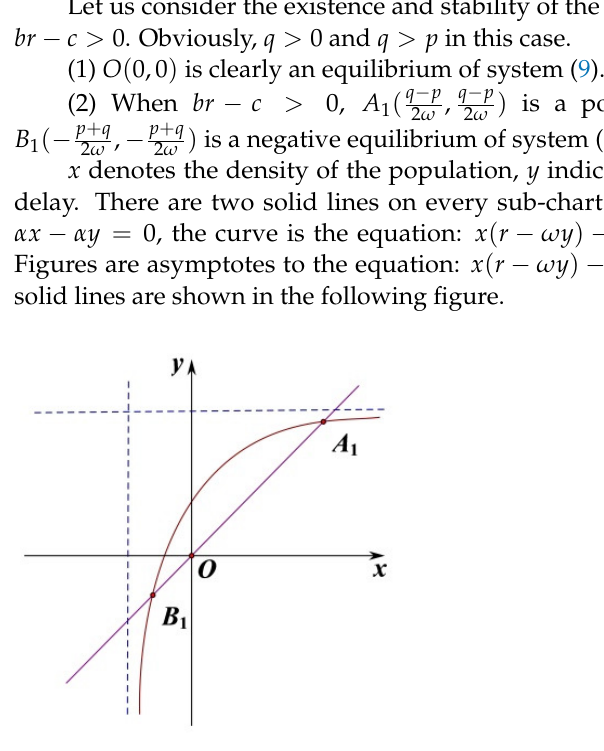
Figure 1. The locations of the equilibria under the case br − c > 0. x denotes the density of the population and y indicates the impact of distributed time